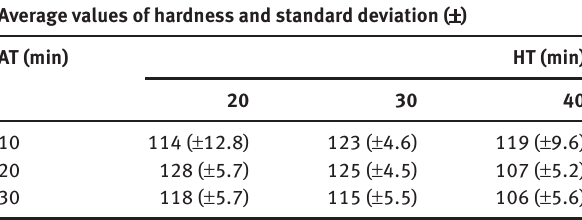
Table 4: Average hardness variation with respect to HT and AT. Average values of hardness and standard deviation ( ± ) AT (min)